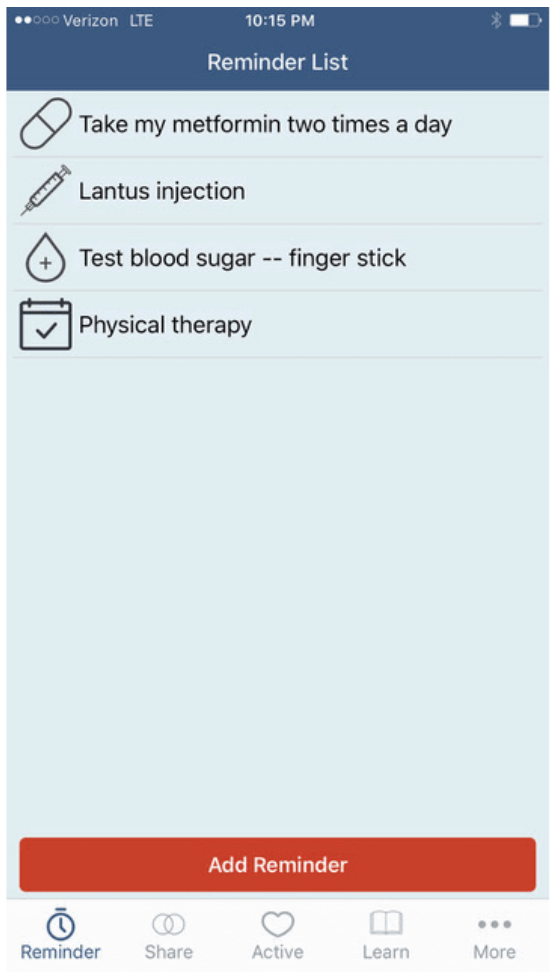
Figure 3. Initial screen when in the process of setting a new reminder in the